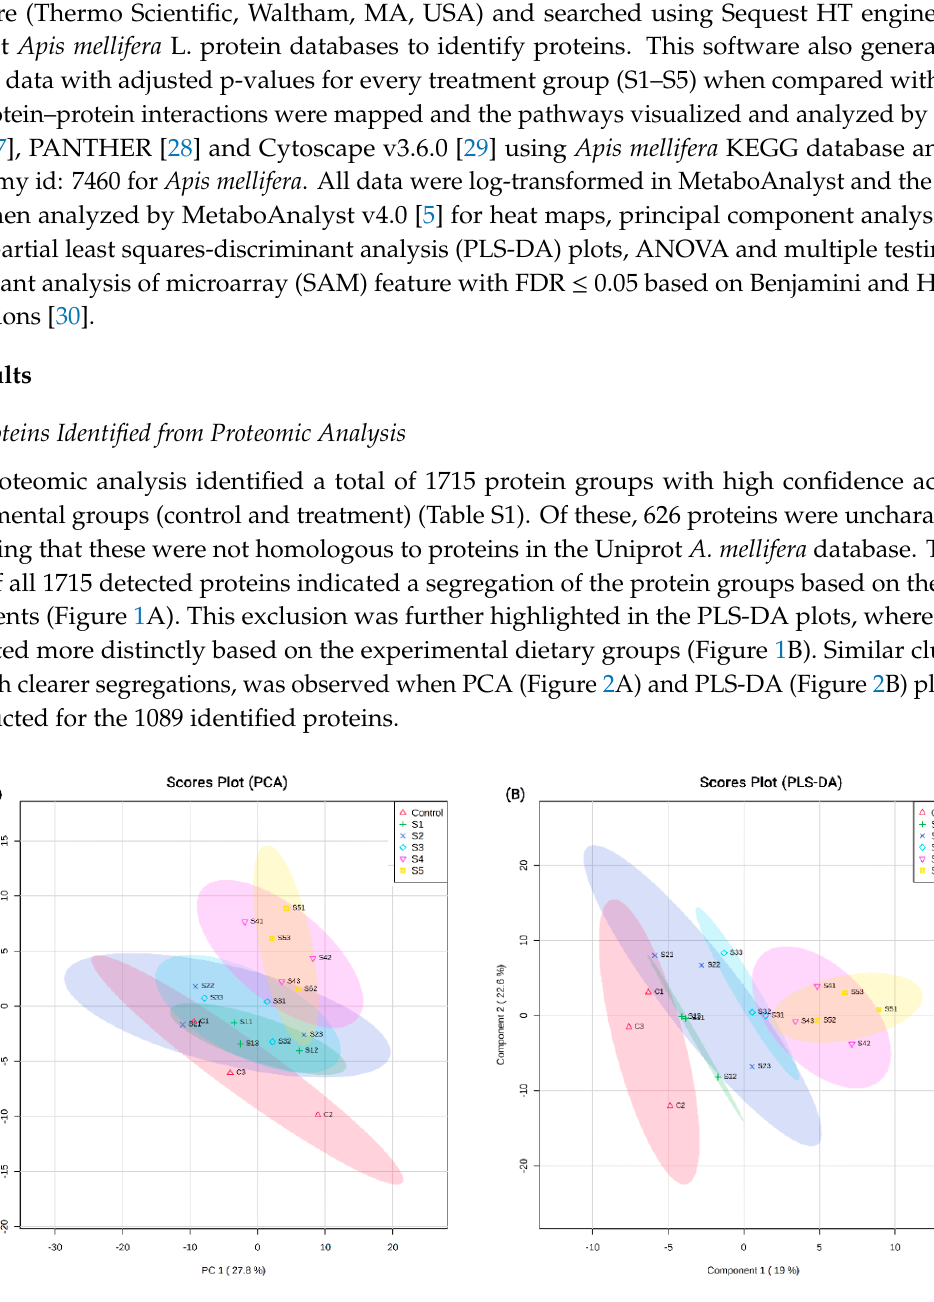
Figure 1. ( A ) Principal component analysis (PCA) plots and ( B ) partial least squares-discriminant analysis (PLS-DA) plots generated by MetaboAnalyst showing the clustering of 1715 detected proteins across the different experimental groups. C indicates control. S1–S5 indicate dietary groups